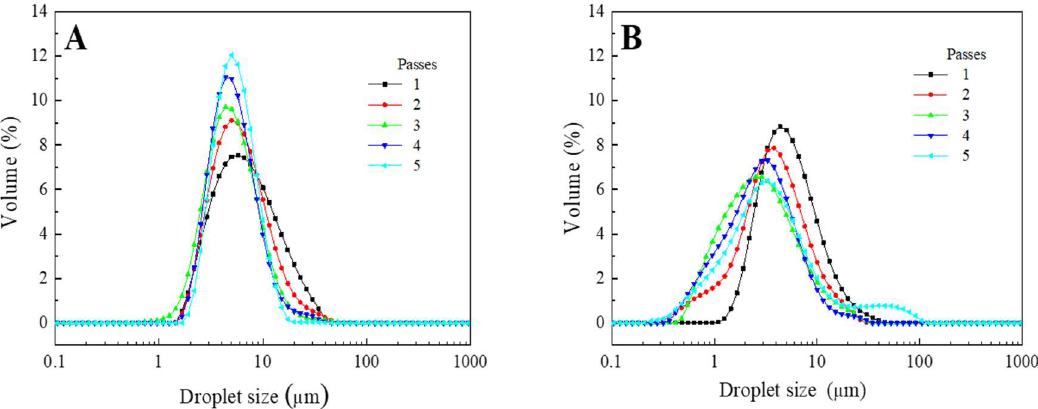
Figure 1. Droplet size of W 1 /O/W 2 multiple emulsions obtained after processing the secondary emulsion at 5 MPa ( A ) and 20 MPa ( B ), as a function emulsion passes through the high-pressure homogenizer.